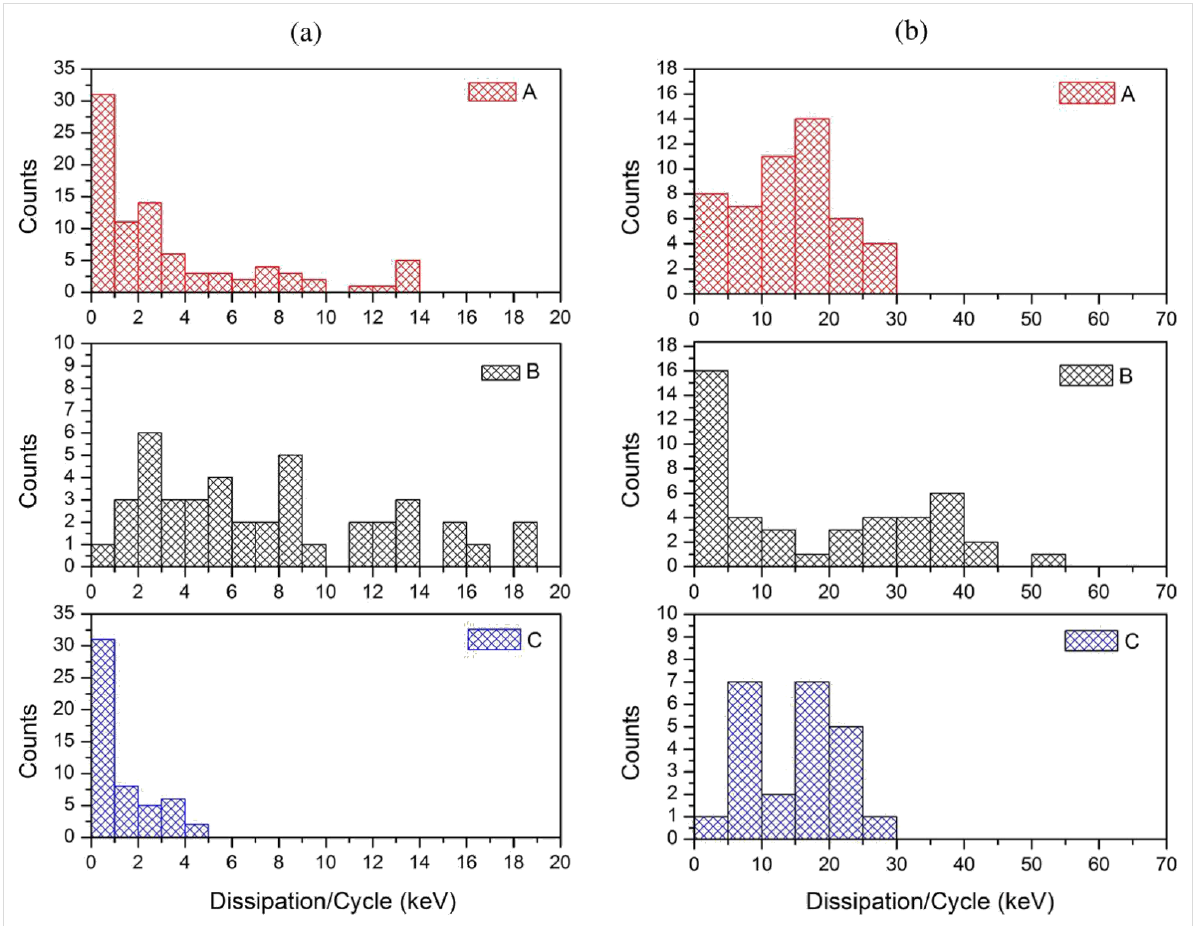
Figure 4: Calculated energy dissipation histograms obtained for the nanoparticles A, B and C from Figure 3 on mica (a) and tooth enamel (b). The dissipated power was calculated per oscillation cycle of the cantilever. Amplitude and set point were comparable for all experiments.